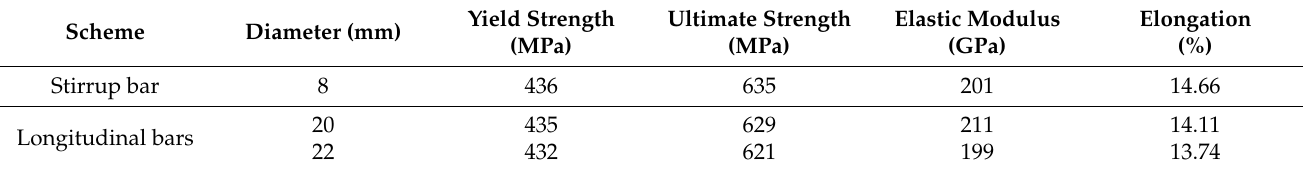
Table 7. Material properties of the reinforcing bars.